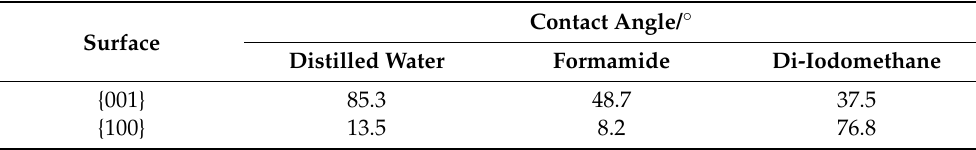
Table 2. Average contact angle values measured by the droplet of three liquids on each commonly exposed surface of molybdenite.